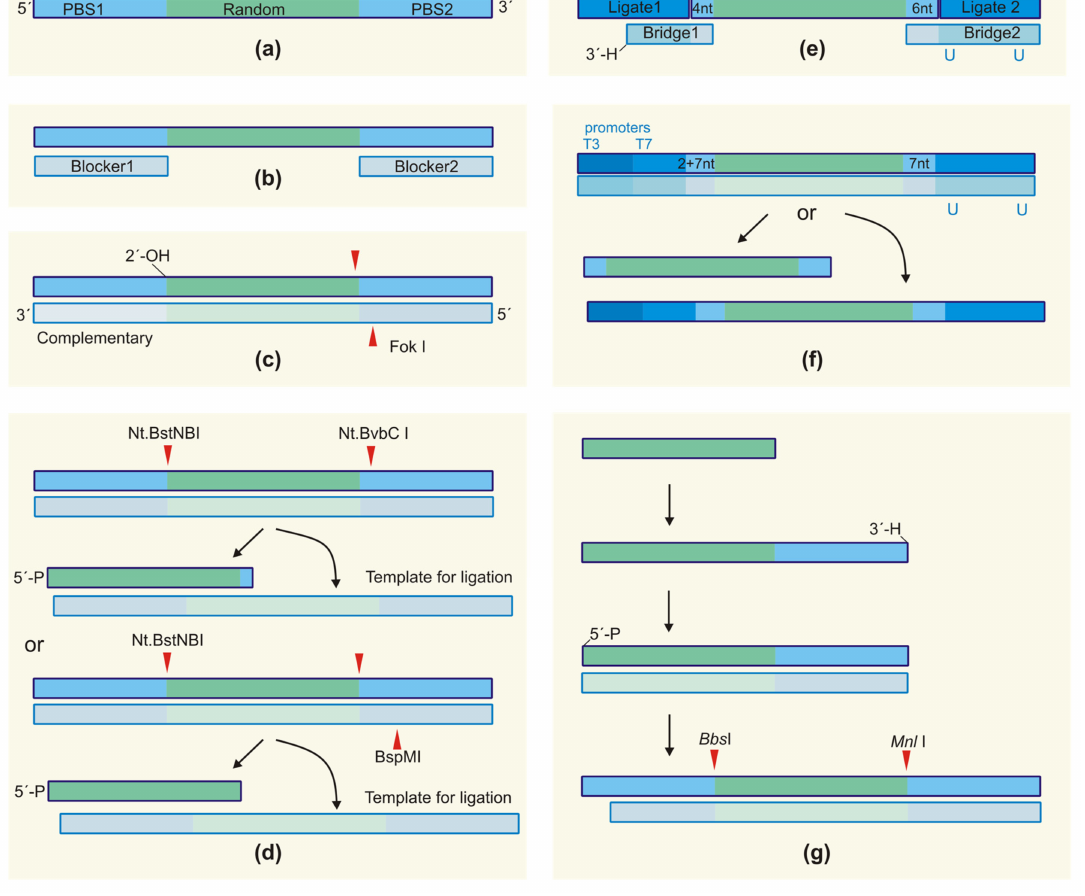
Figure 3. Different variants of design for NA libraries for a primer-free SELEX. ( a ) A conventional NA library; ( b ) blocked primer-binding sites for primer-annealing SELEX [62]; ( c ) the